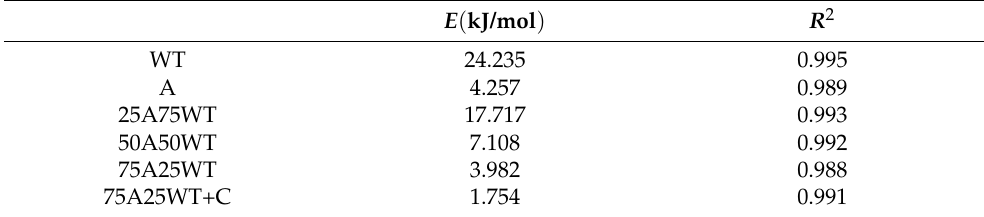
Table 5. Activation energy and correlation coefficient obtained by CR